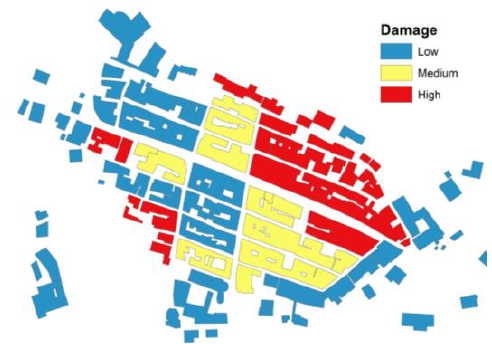
Figure 4: Damage classification in the historical